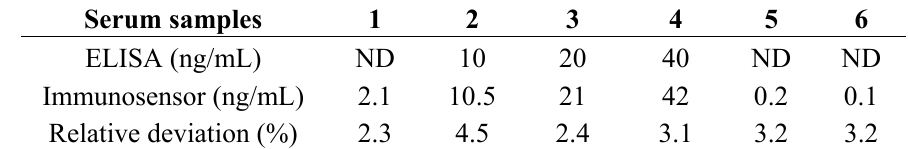
Table 2. Experimental results comparison of two methods obtained in serum samples (n = 3). Serum